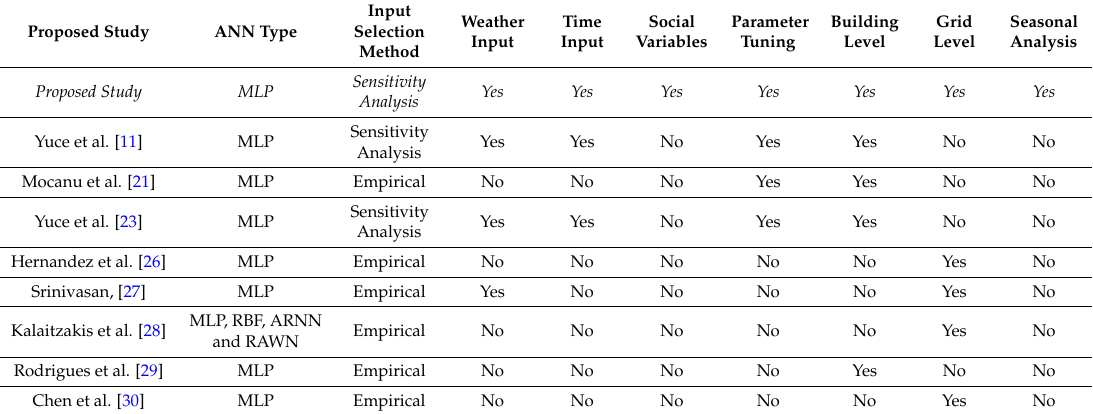
Table 9. ANN parameter comparison between the proposed work and existing